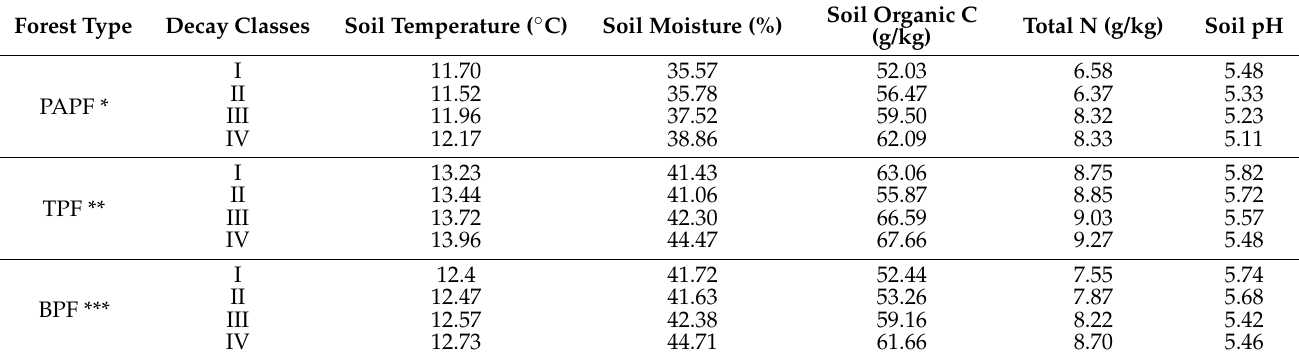
Table 1. Mean data of soil physical and chemical properties across different forest types; Abbreviations: C, carbon and N, Nitrogen. Forest